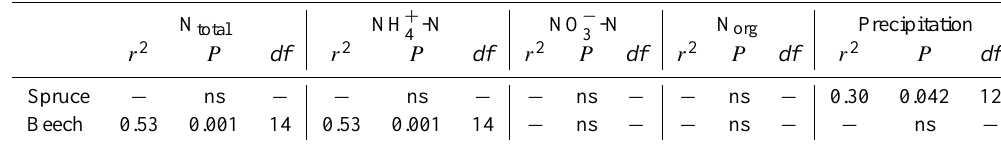
Table 4. Results of the regression analyses of N 2 O-N fluxes and throughfall N depositions (total N, NH + depositions) and